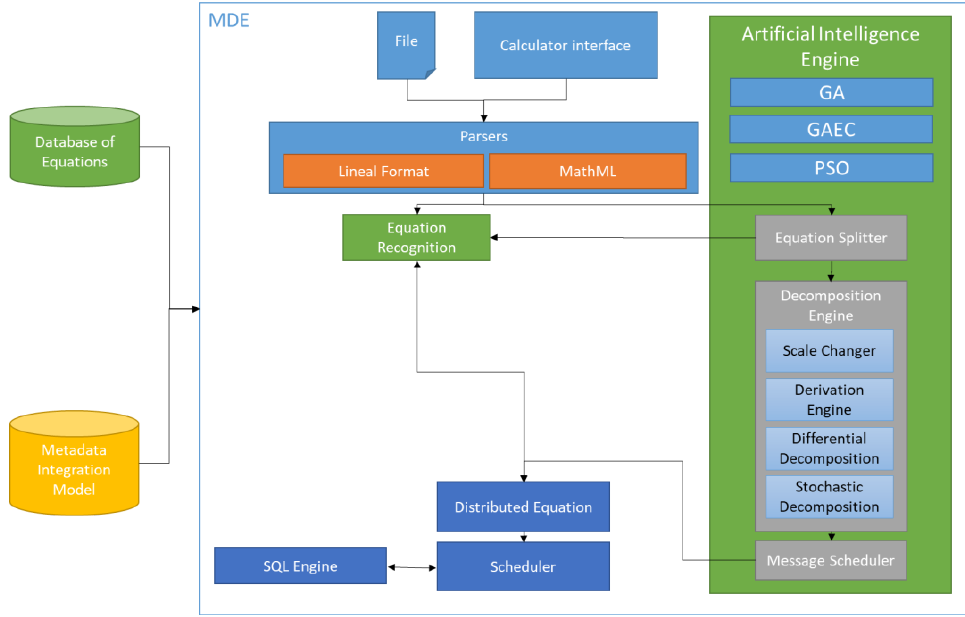
Figure 3. Master node architecture, Mathematical Decomposition Engine (MDE).